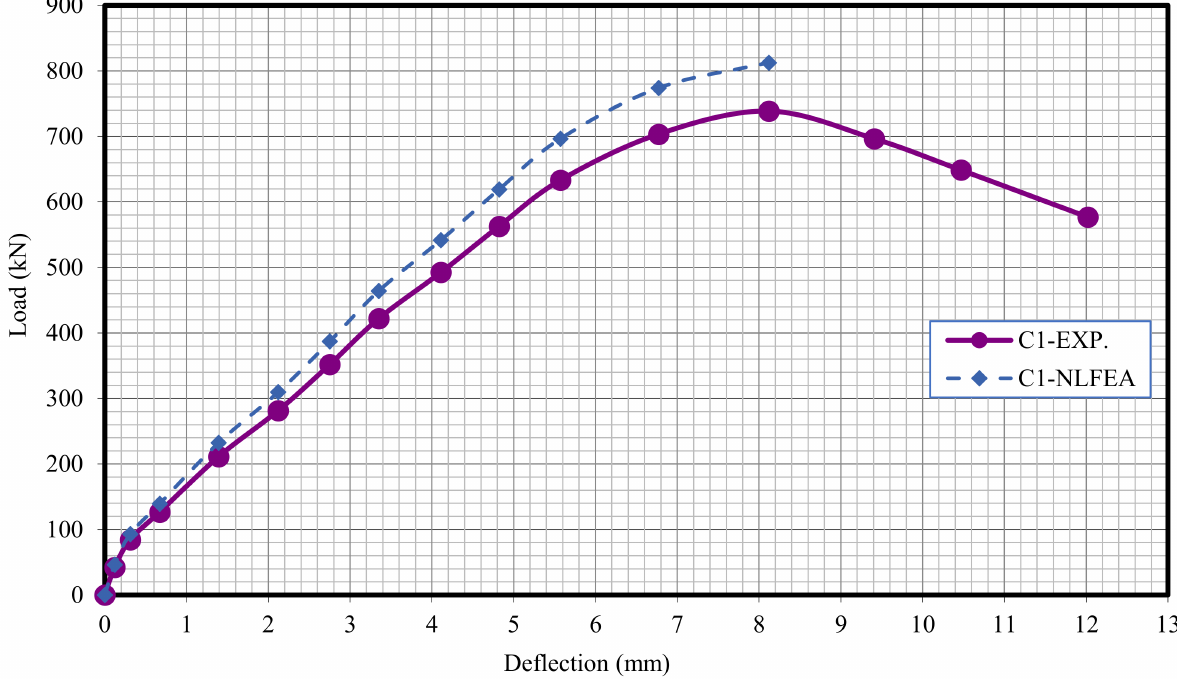
Figure 21. Load deflection of Column C1.